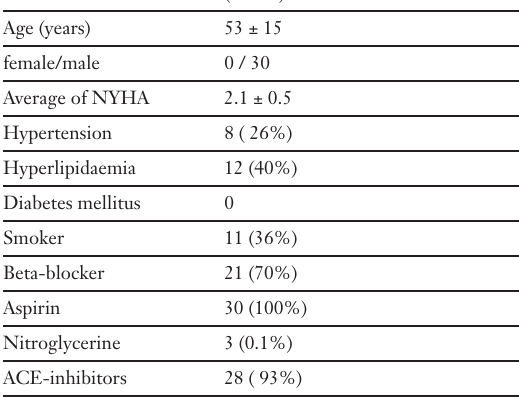
Overall characteris- tics and comedica- tions of the